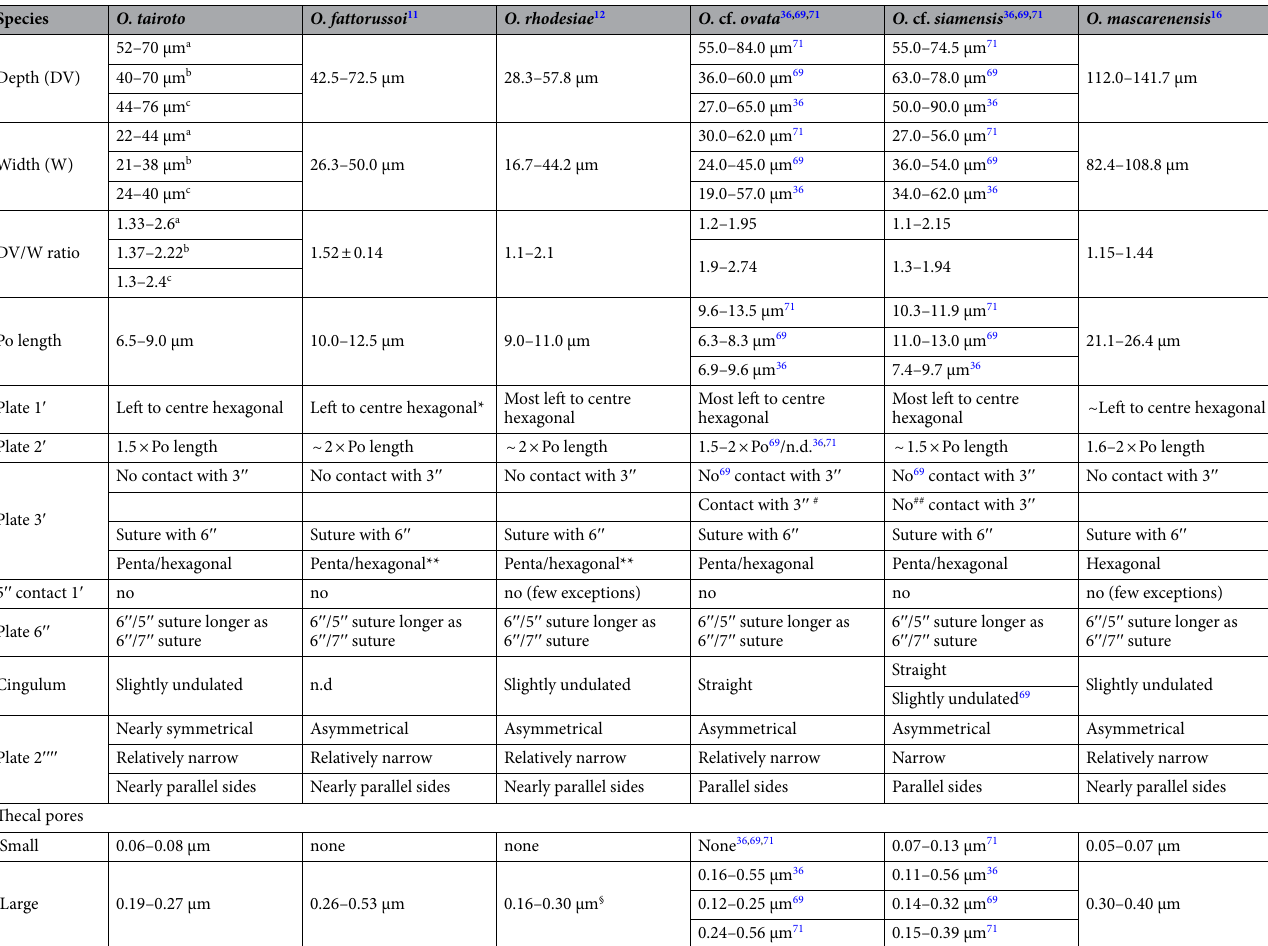
Table 3. Morphological comparison between Ostreopsis species closely related to O. tairoto . a,b,c represent DV, W and DV/W ratio measurements obtained from O. tairoto strains O1C6, CAWD268 and CAWD270 respectively. *described as heptagonal but hexagonal on Figs. 2A, 4A and 5A (Accoroni et al. 11 ); **counting sutures it is hexagonal but as the very short suture with the Po plate is not recognized in lower magnification it looks pentagonal on most images; # David et al. 69 : contact described in text, but see their Fig. 6A; ## David et al. 69 : contact described in text, but see their Figs. 3A,D and 4A and Penna et al. 36 Fig. 3A. § measured on original SEMs (n = 40) from Verma et al. 12 .